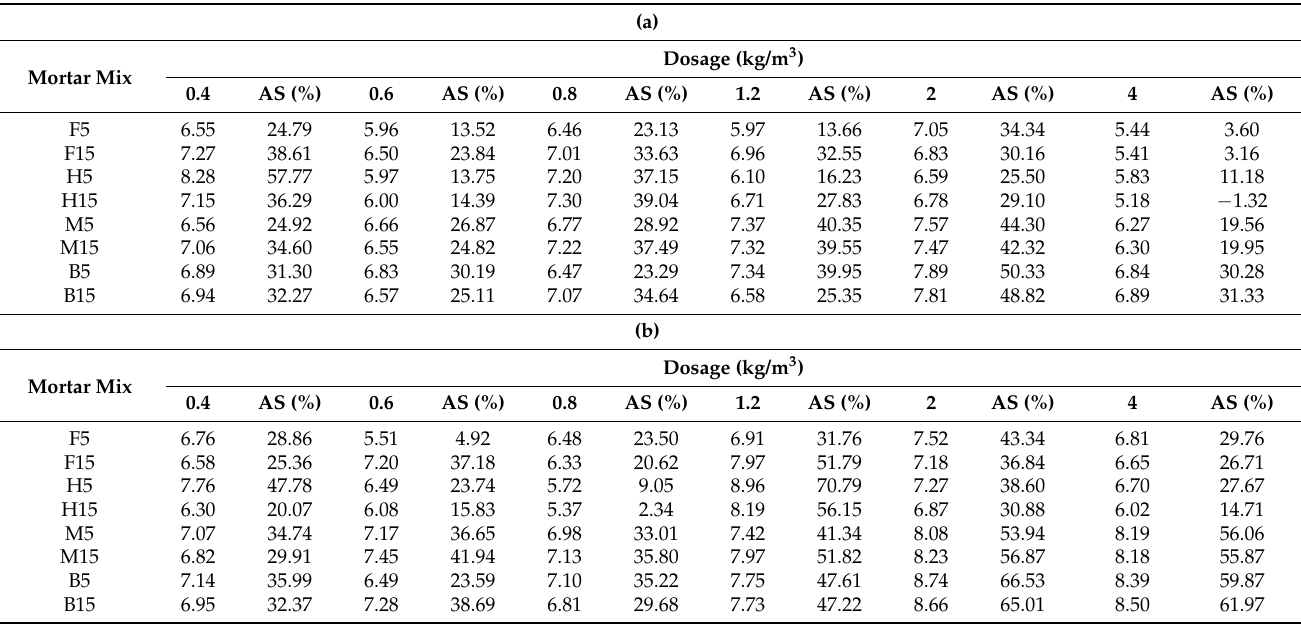
Table 9. ( a ) Flexural strength (FS) at 28 days (MPa) mean value measured on three specimens for each mortar mix. ( b ) Flexural strength at 90 days (MPa) mean value measured on three specimens for each mortar mix. AS: antifissuration screed mortar (0.6 kg/m 3 of fiber dosage)—Flexural strength range respect AS; Flexural strength AS: 5.92 MPa.